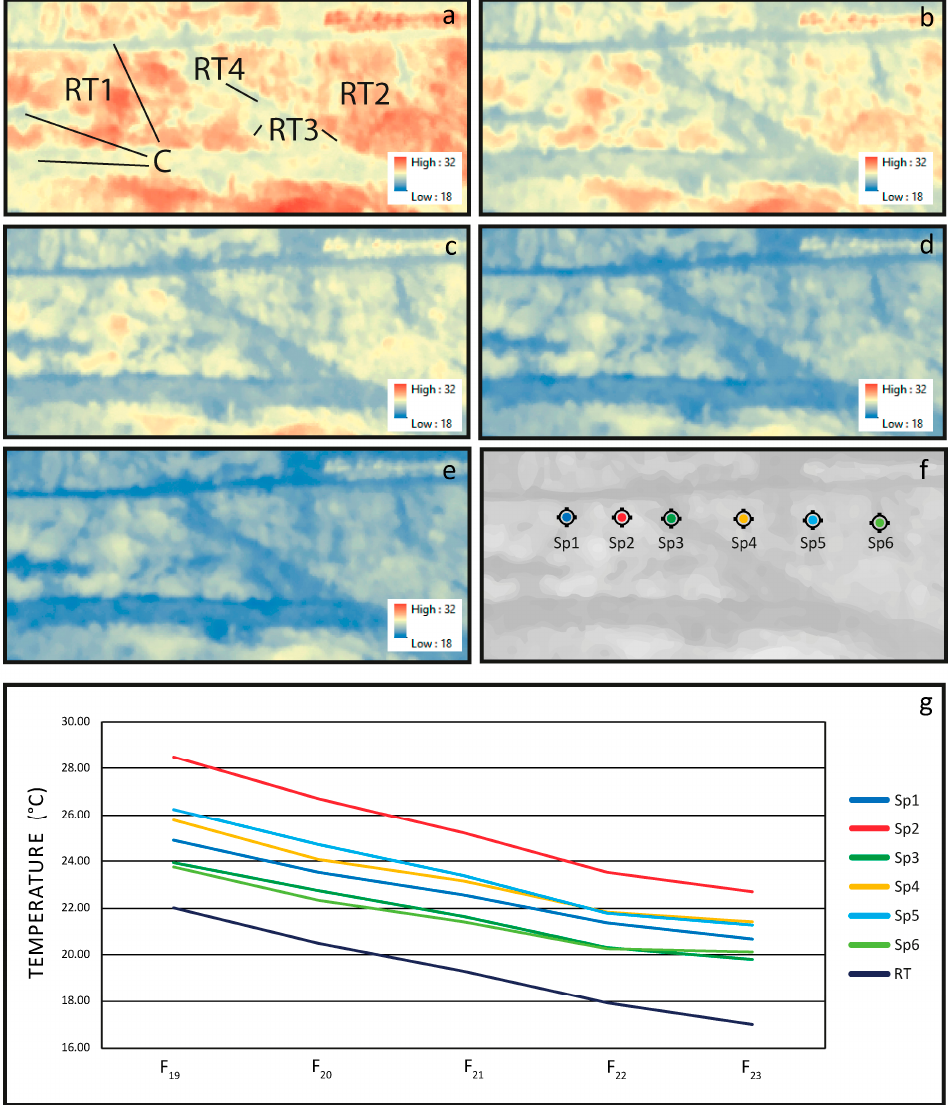
Figure 9. Summer measurement session ( a ) = image at 19:00 (F 19 ), ( b ) = image at 20:00 (F 20 ), ( c ) = image at 21:00 (F 21 ), ( d ) = image at 22:00 (F 22 ), ( e ) = image at 23:00 (F 23 ), ( f ) = position of measurement points, and ( g ) = temperature trends of the spot measurement points. RT stands for the ambient temperature.